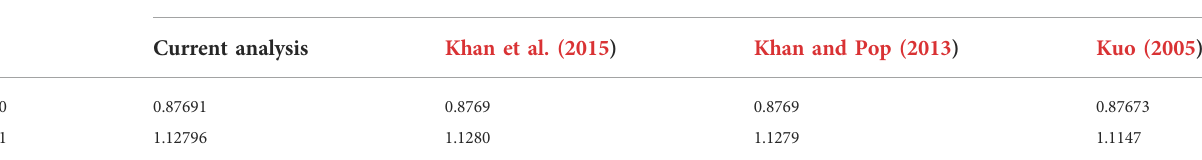
TABLE 3 Comparative study on heat transfer for pure fl uids with α (cid:1) 0 and λ (cid:1) M (cid:1) Ec (cid:1) 0. m − θ 9 ( 0 ) Current analysis Khan et al.